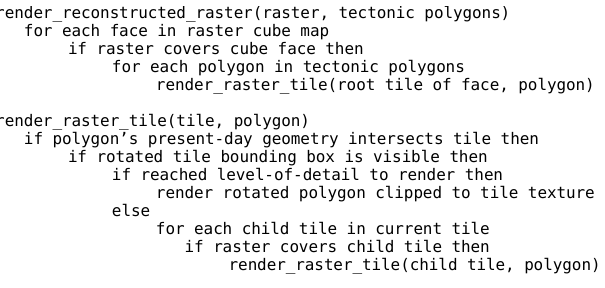
Figure 7. Pseudocode for the rendering traversal of a reconstructed multi-resolution cube map raster.